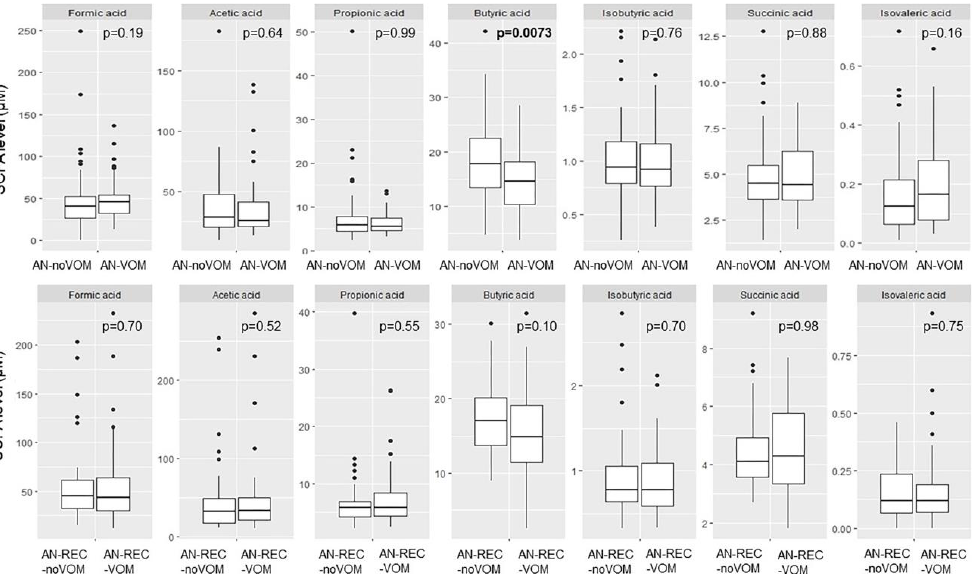
Figure 4. Box plots illustrate group differences in adjusted plasma concentration of SCFA in active and recovered AN with (AN-VOM, AN-REC-VOM) and without (AN-noVOM, AN-REC-noVOM) documented self-induced vomiting. The median is shown as a straight line and the box denotes the interquartile range. p < 0.017 is considered significant. We also see a significant difference with reported binge eating in the AN-REC group; lower plasma isovaleric acid in AN-REC-B compared with AN-REC-noB (Figure 5), whereas no significant differences were seen in active AN patients with or without re- ported binge eating (Figure 5).